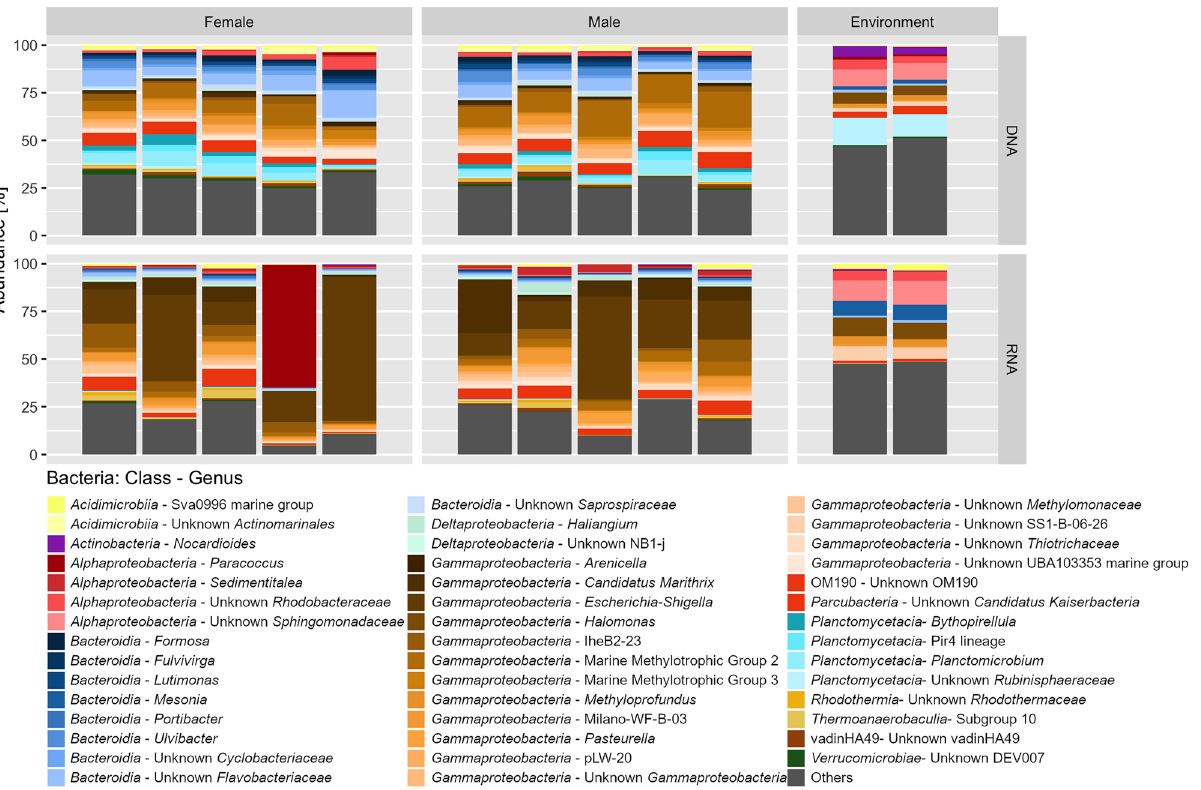
Figure 6. Abundance of bASVs in sea water and M. alvisca samples, displayed on genus-level or, if that was not possible, on the next identifiable superordinated rank. Others: taxa with < 0.5% abundance.